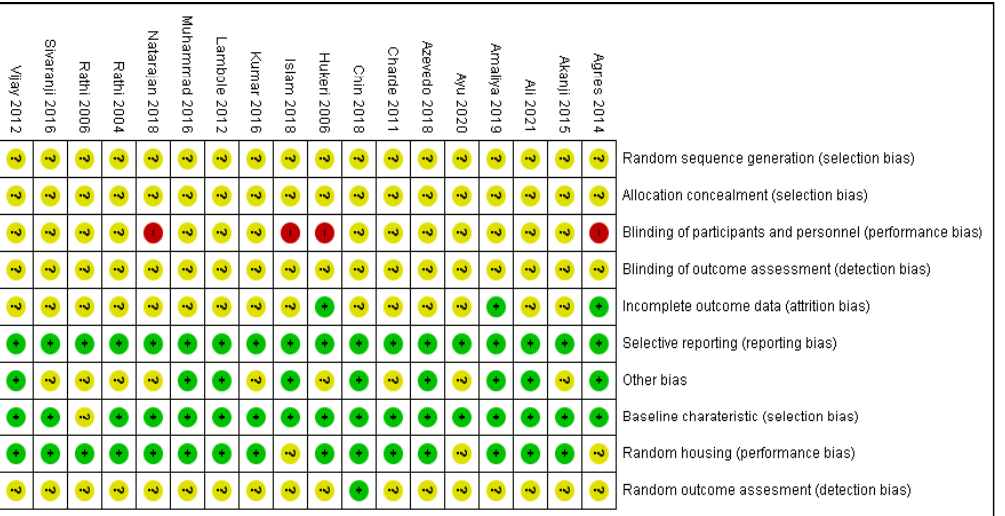
Figure 3. Risk of bias assessment of included studies of M. oleifera for wound healing: Green for low risk of bias, yellow for unclear risk of bias and red for high risk of bias.